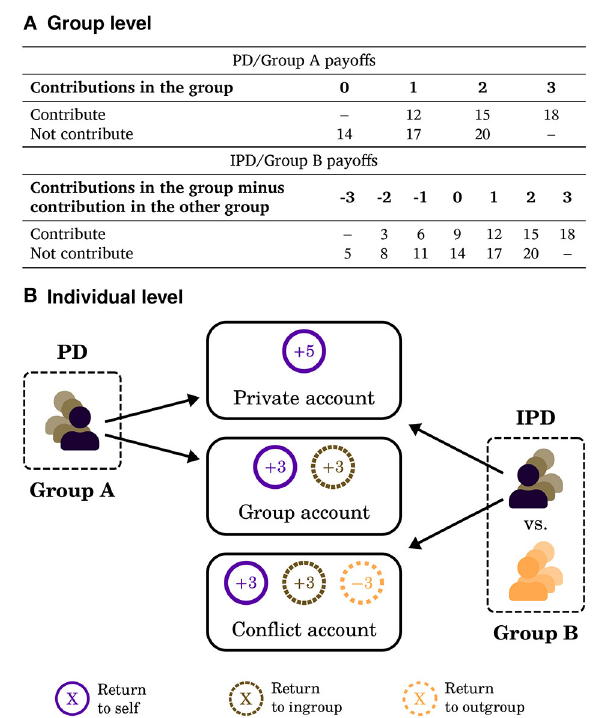
FIGURE 1 | The IPD and PD games. Contributions are made to a group account in the PD and to a conflict account in the IPD. Panel (A) presents the payoff to the player based on the total contributions (columns) and her own contribution (rows). Panel (B) presents the same games as the change in payoff based on all players’ choices between contributing and investing in a private account compared to a base endowment of 14. The player faces a choice between a private account and a group account. In the IPD, the choice is between a private account and a conflict account. The labels “Group A” and “Group B” refer to the asymmetric game that combines features of the PD and the